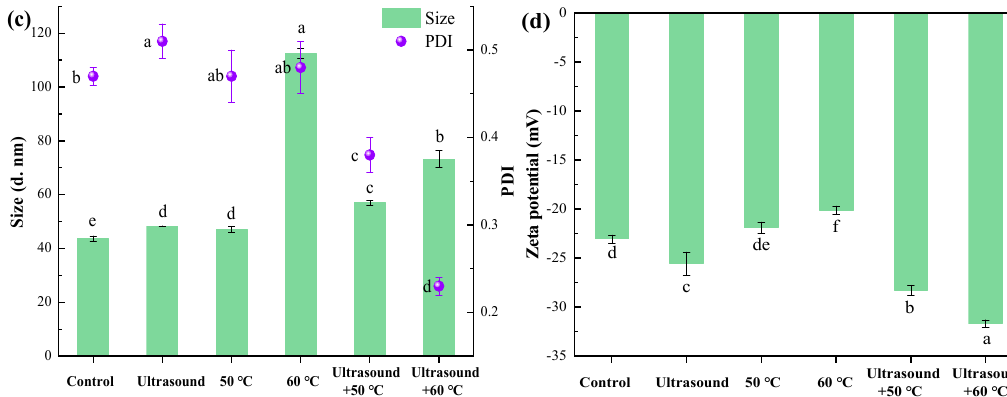
Figure 4. Zeta potential and particle size distribution of 11S ( a ): Intensity% distribution; ( b ): Volume% distribution; ( c ): Value of size and PDI; ( d ): Zeta potential) ( p < 0.05, RM ANOVA, Duncan test).